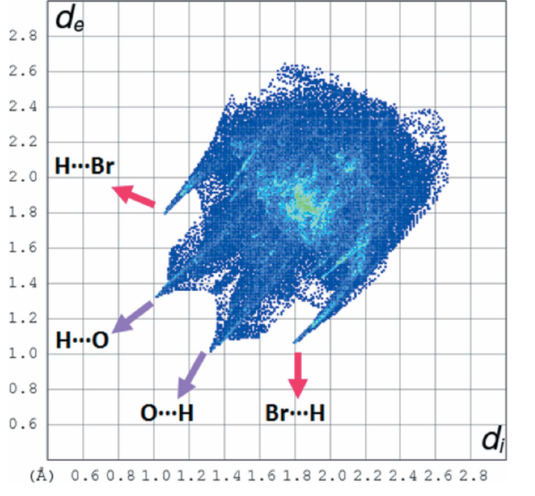
Figure 4 Fingerprint plot of the title compound showing all interactions.